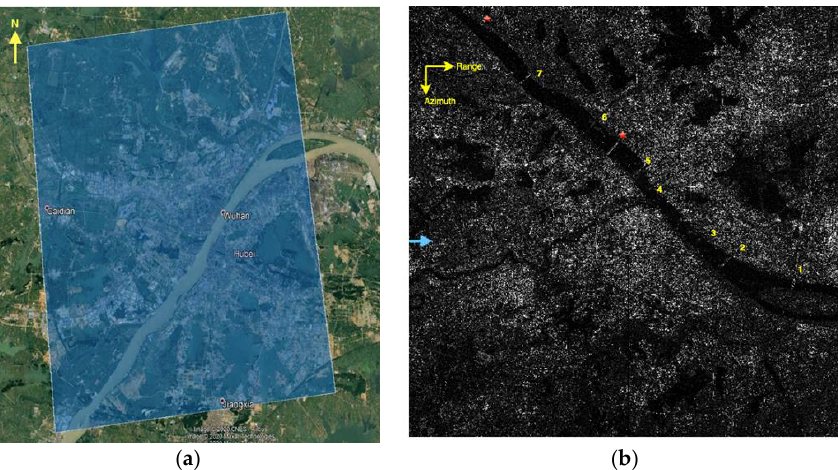
Figure 1. ( a ) Study area of Wuhan (China) with the footprint of the COSMO-SkyMed StripMap HIMAGE scenes. ( b ) Synthetic aperture radar (SAR) amplitude image of the area (the blue arrow on left side indicates the looking direction) in radar geometry, with indication of the seven bridges